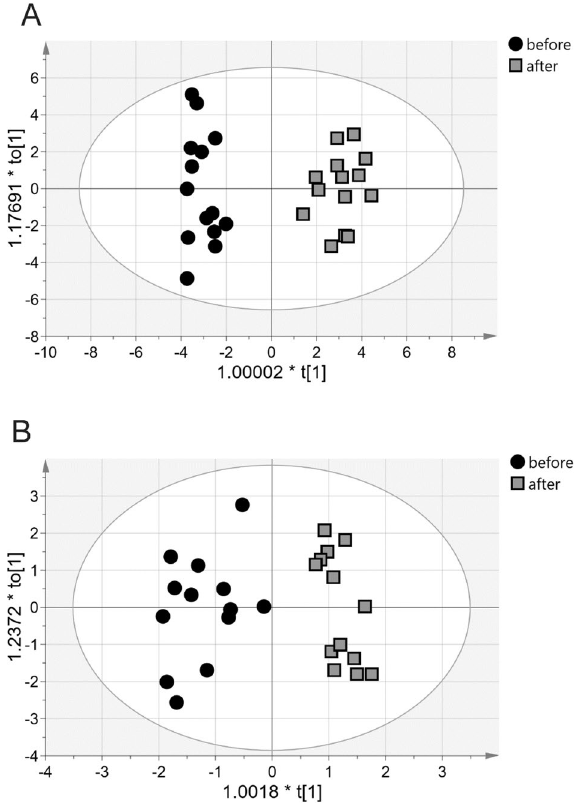
Figure 1. Score plots of the two-component OPLS-DA. ( A ) Biochemical clinical data of before and after exercise training groups. ( B ) NMR spectroscopy lipids data of before and after exercise training groups. t o [1] represents variations within class for the first orthogonal component, whereas t[1] represents variations between classes for the first predictive component. Ellipse represents Hotelling’s T2 with 95% confidence interval. OPLS-DA orthogonal partial least squares discriminant analysis, NMR nuclear magnetic